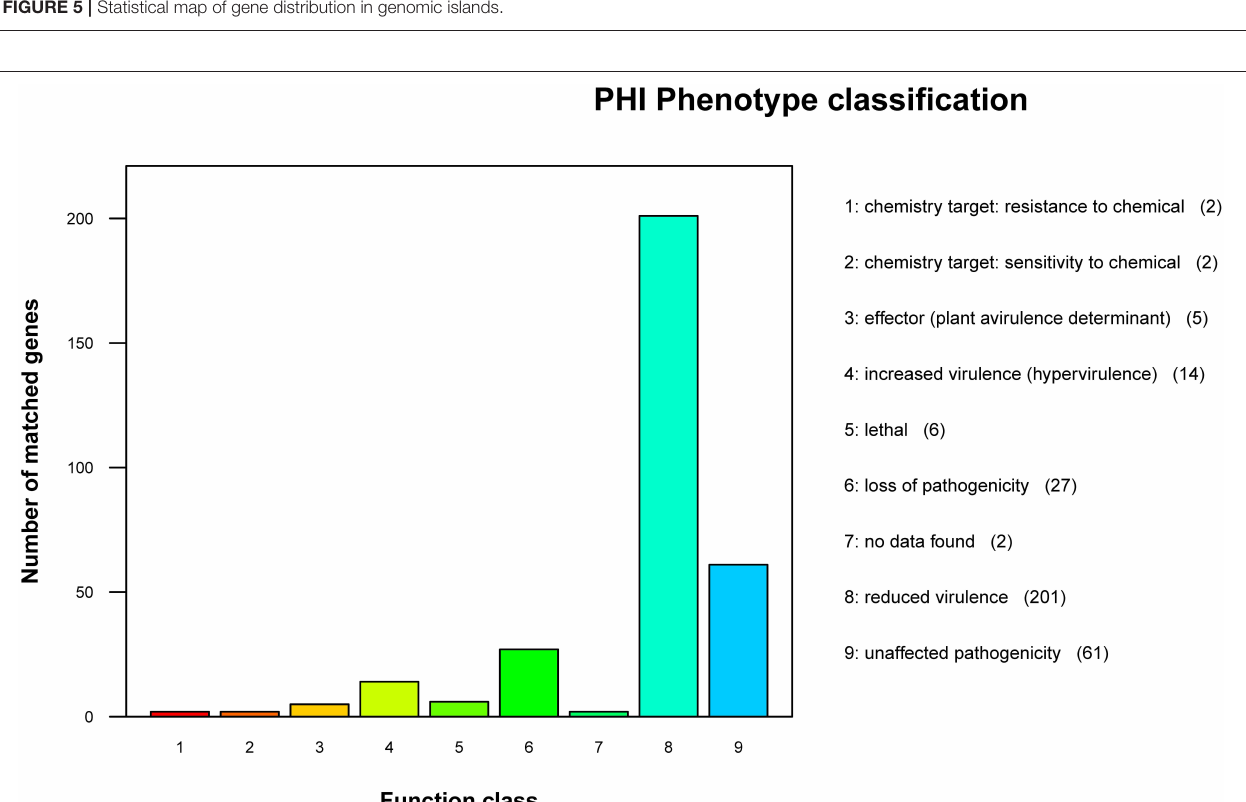
FIGURE 5 | Statistical map of gene distribution in genomic islands.